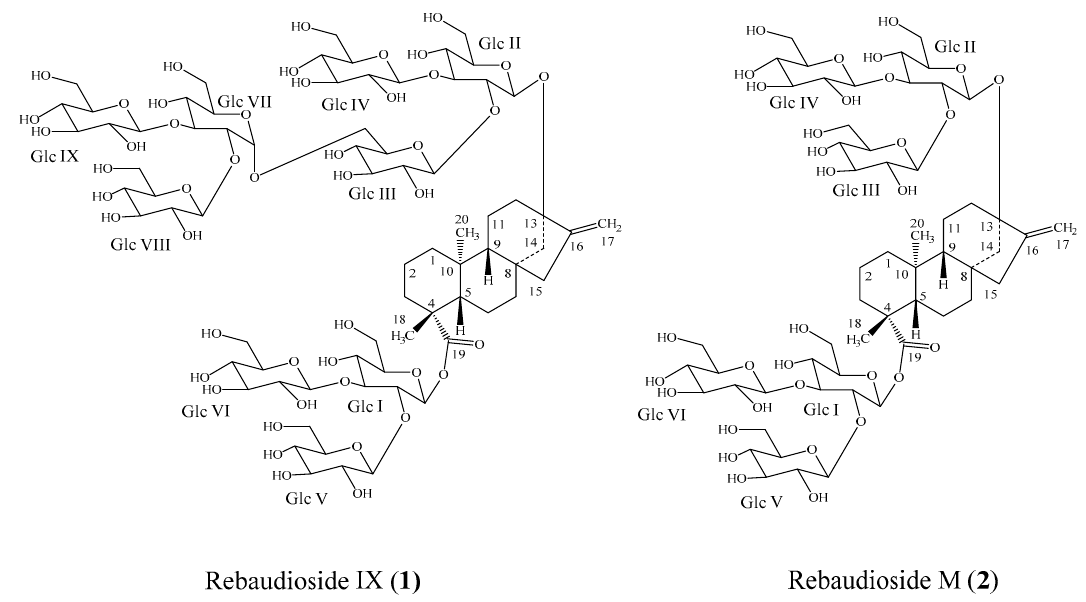
Figure 1. Structures of Rebaudioside IX ( 1 ) and Rebaudioside M ( 2 ).